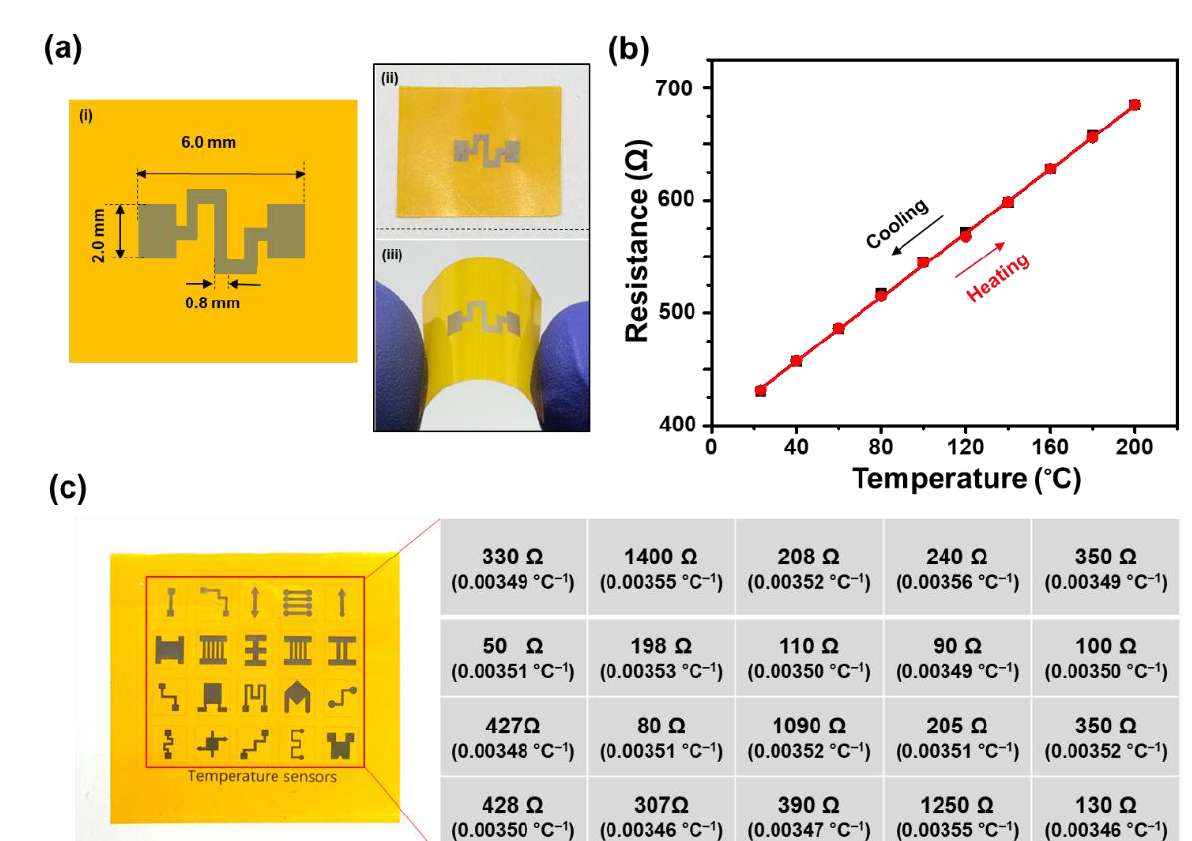
Figure 5. ( a ) Schematic drawing of the Ni-based resistance temperature detector (RTD) ( i ) and photo images of the real sample ( ii and iii ). ( b ) The resistance variation with temperature of showing a linear relationship. ( c ) The reference resistance values and the corresponding temperature coefficient of resistance ( α ) values of the Ni-based RTDs of various shapes. Each set of values corresponds to the RTD of the designated position.